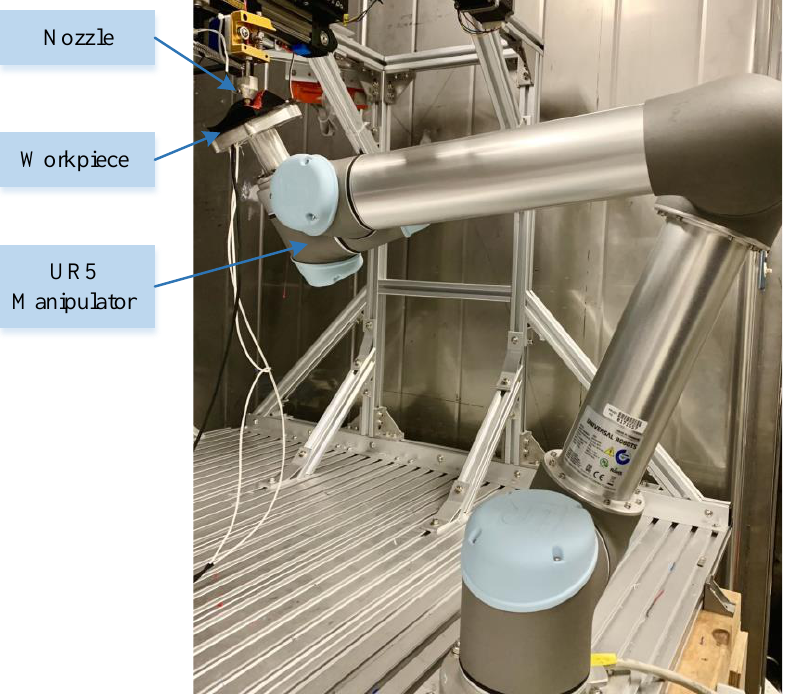
Figure 7. A homebuilt robotic manipulator-based multi-axis FDM printing system. Table 1. Processing parameters.